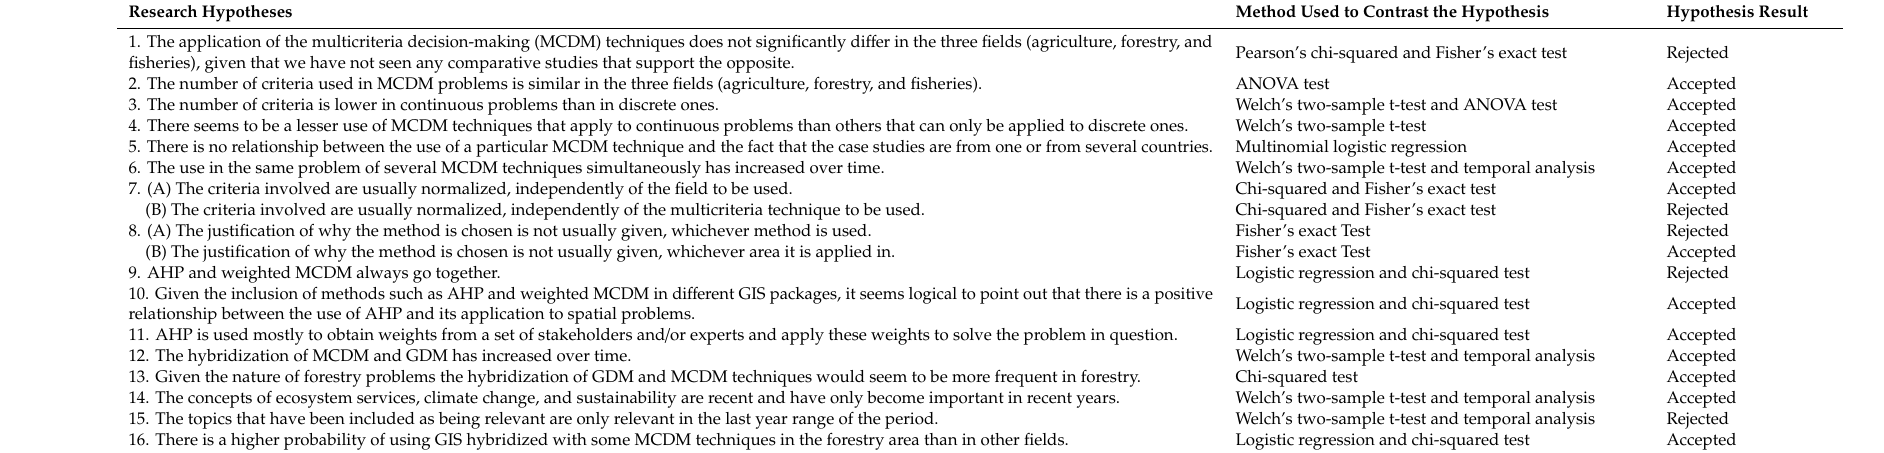
Table 5. Research hypotheses, methods used to contrast the hypotheses and